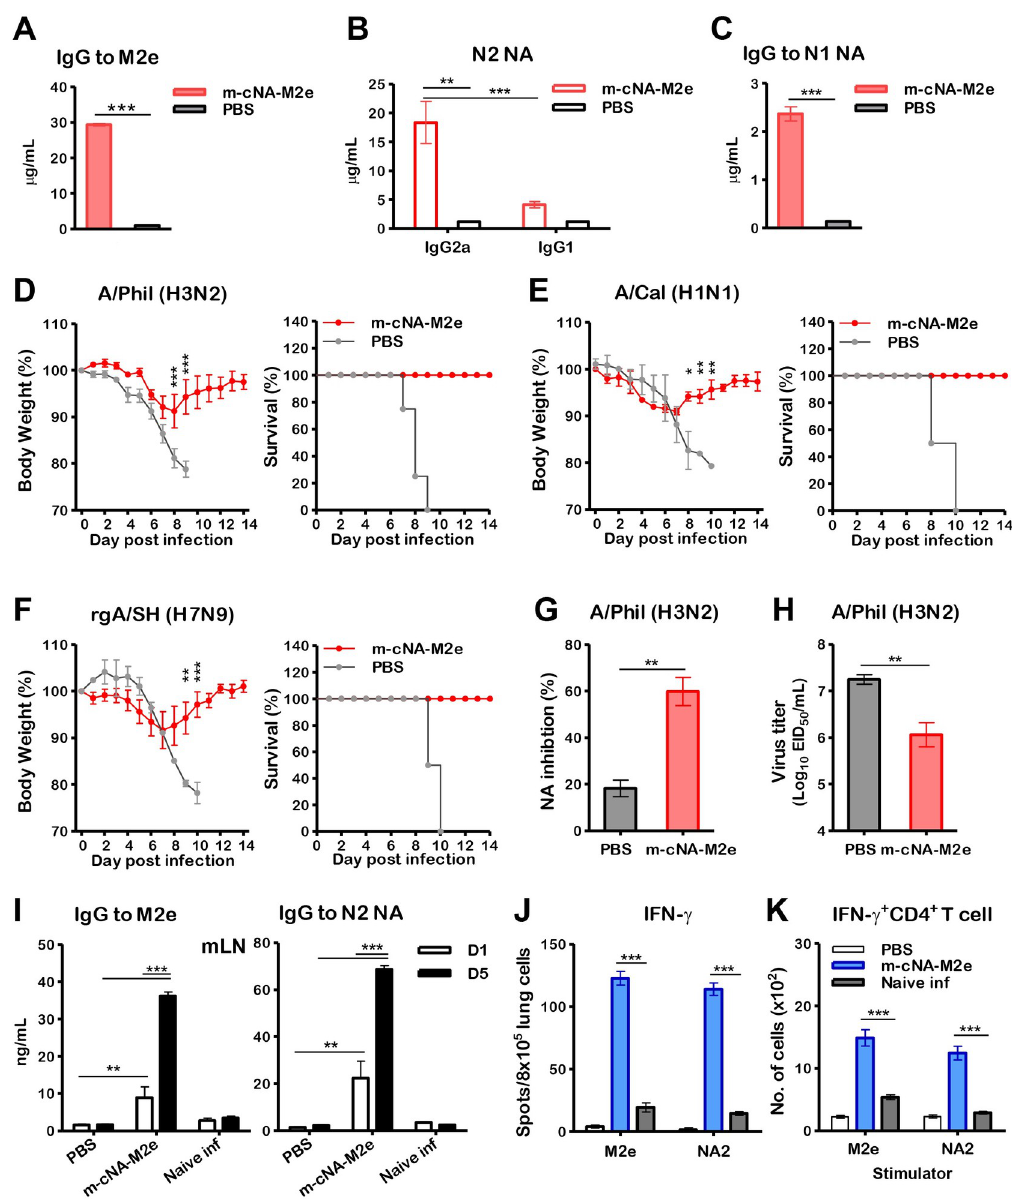
Fig 6. m-cNA-M2e VLP vaccination induces humoral and cellular immune responses and confers cross protection against influenza A viruses in aged mice. BALB/c mice (14-months old, n = 10 per group) were intramuscularly immunized with m-cNA-M2e VLP (10 μ g) prime-boost at a 3-week interval. (A-C) Concentrations of IgG and isotype antibodies specific for M2e, N2 NA (A/Brisbane/10/2007 H3N2), and N1 NA (A/California/4/2009 H1N1) protein in boost immune sera from aged mice. (D-F) Body weight changes monitored daily for 14 days and survival rates after challenge with influenza A viruses. (D) A/Phil/1982 H3N2 (3xLD 50 , 7x10 EID 50 ), (E) A/Cal/2009 H1N1 (3xLD 50 , 2x10 4 EID 50 ), (F) rgA/SH/2013 H7N9 (H7 HA, N9 NA from A/Shanghai/2013) (3xLD 50 , 5.6x10 3 EID 50 ). (G) NA inhibition activity in 40-fold diluted boost immune sera against A/Phil (H3N2) virus by ELLA. (H) Lung viral titers at day 6 post infection with A/Phil (H3N2). (I) Antigen-specific IgG levels in mLN cells collected at day 6 post challenge with A/Phil (H3N2) after in vitro culture with M2e (4 μ g/ml) or N2 NA protein (A/Brisbane/10/2007 H3N2, 200 ng/mL) for 1 (D1) or 5 (D5) days. (J) IFN- γ cytokine secreting spots in lung cells after stimulation with 5 μ g/mL of M2e or N2 NA (A/Brisbane/10/2007, H3N2) pooled peptide. (K) IFN- γ secreting CD4 T cells in lungs after in vitro stimulation with 5 μ g/mL of M2e or N2 NA pooled peptide by intracellular cytokine staining and flow cytometry. The statistical significances were performed with one-way ANOVA with Tukey’s Multiple comparison test or two-way ANOVA with Bonferroni posttest and indicated as � , P < 0.05; �� , P < 0.01; ��� , P < 0.001.